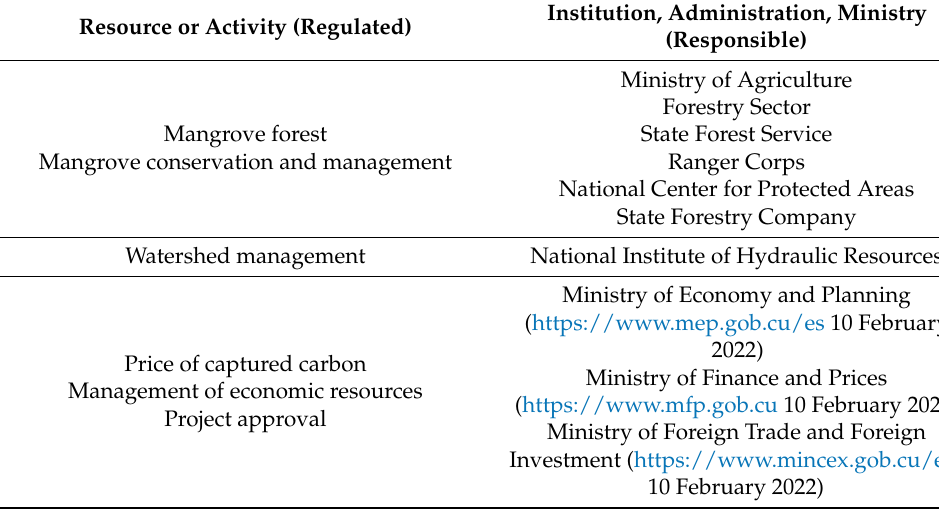
Table 4. Probable administrative framework for mangrove management as a carbon reservoir according to current environmental legislation in